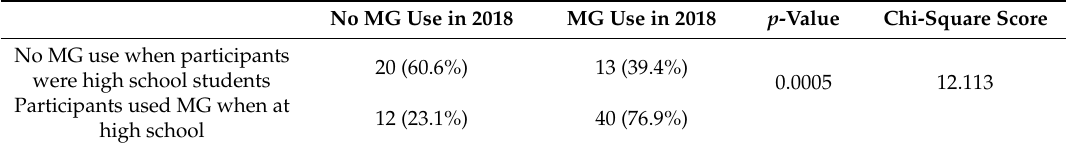
Table 5. MG wearing rates of participants at high school and at the investigation (2018).